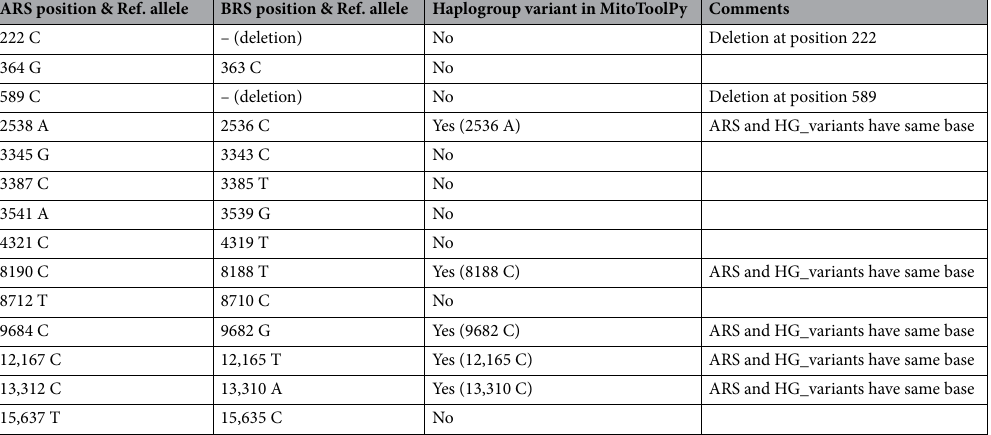
Table 1. Equivalent positions and reference (Ref) alleles differing between ARS-UCD1.2 (ARS) and Bovine reference sequence (BRS) relative to ARS-UCD1.2 and indicating whether variant positions belong to the pre- defined haplogroup variant set as defined in cattleTree_whole.txt file of